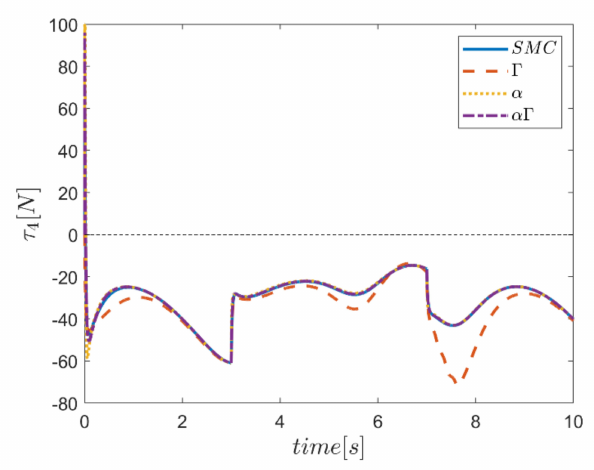
Figure 53. Comparison of input force in the fourth